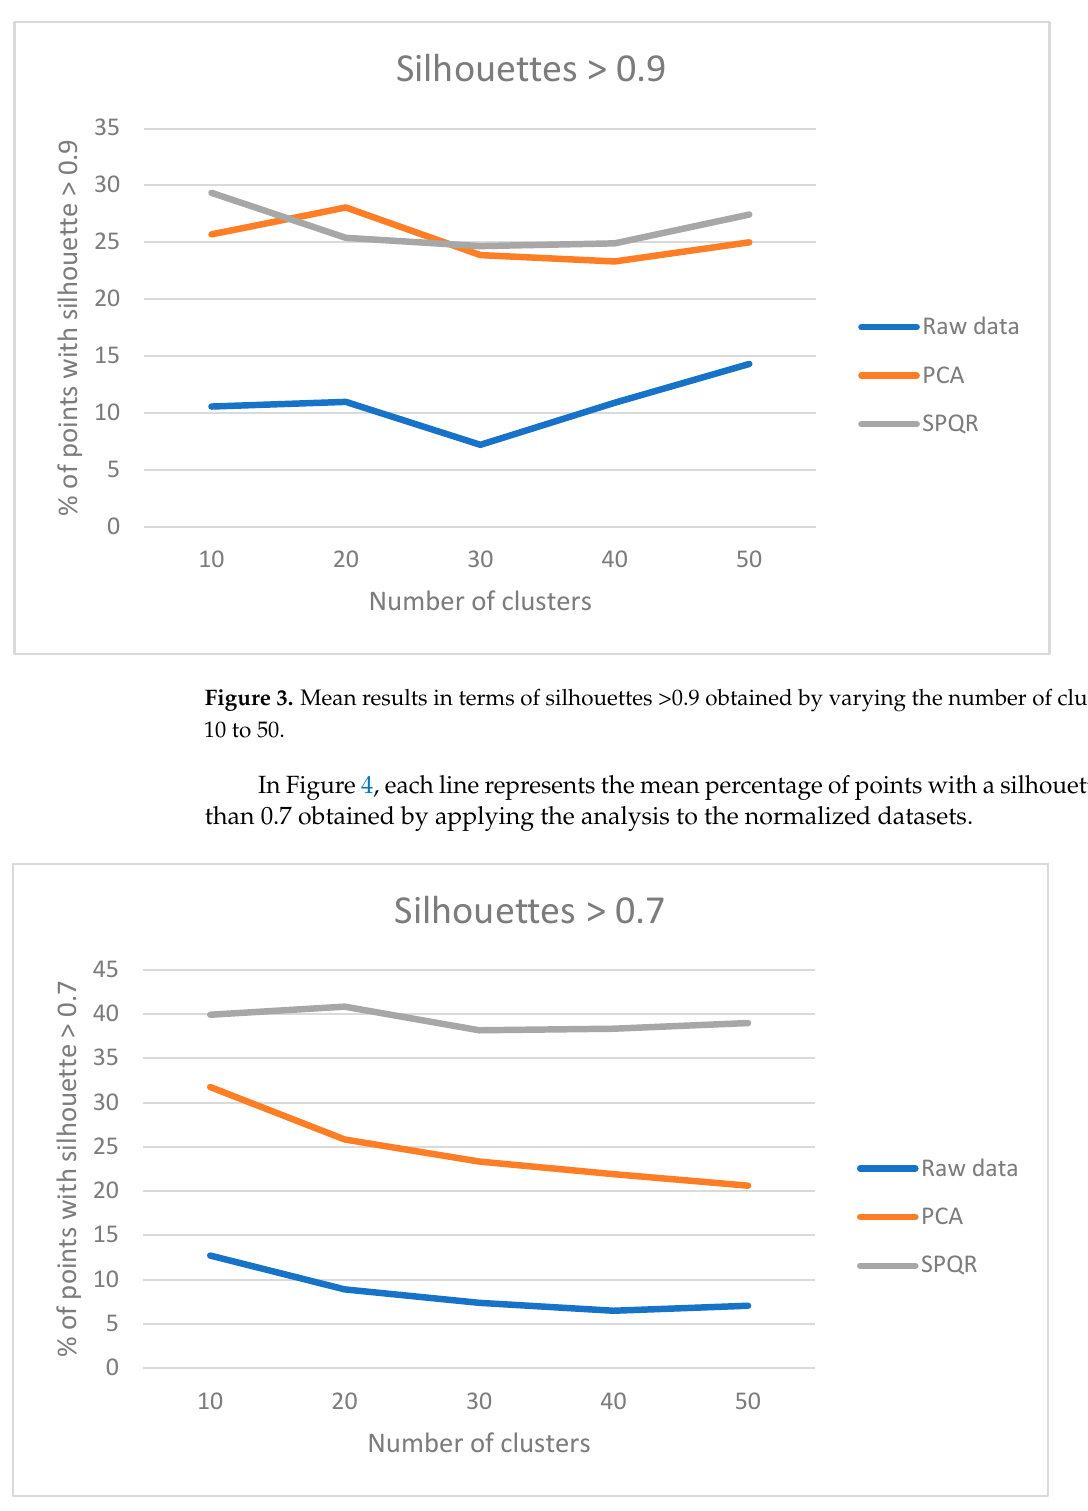
Figure 2. Mean results in terms of silhouettes >0.8 obtained by varying the number of clusters from 10 to 50.